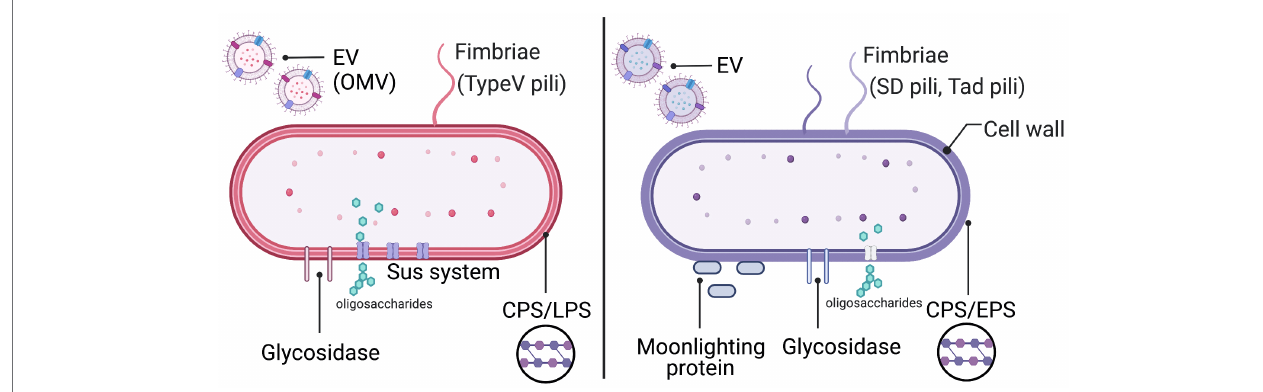
FIGURE 2 | Cell surface architecture of Bacteroides (red) and Bifidobacterium (purple). EV, extracellular vesicle; Sus, starch utilization system; CPS, capsular polysaccharide; LPS, lipopolysaccharide; and EPS, exopolysaccharide. This figure was created using BioRender